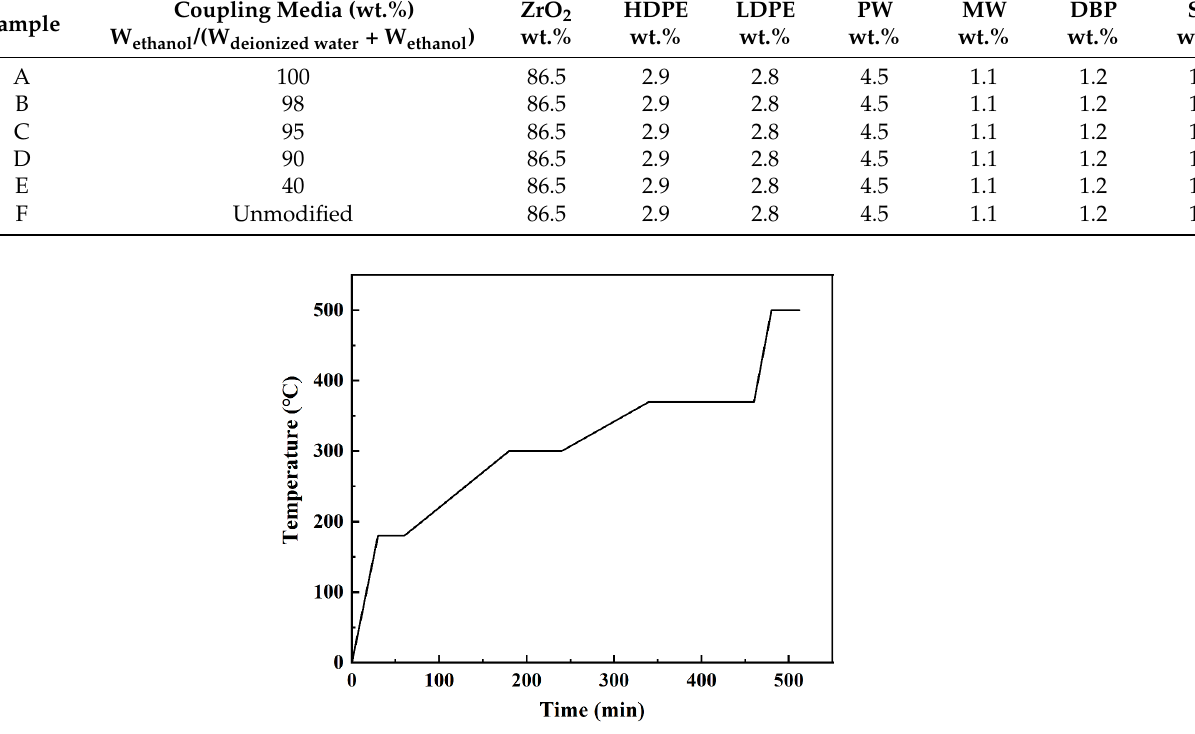
Figure 1. Thermal debinding process for the samples [34].